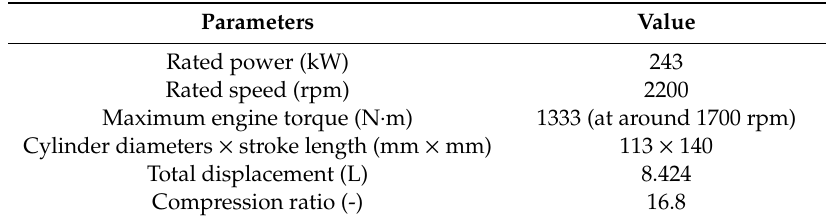
Table 1. Main parameters of the studied diesel engine.